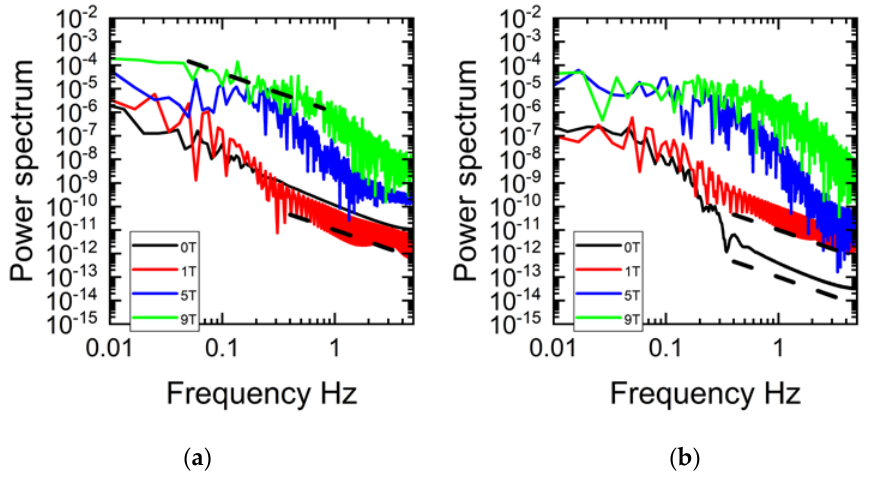
Figure 15. Power spectrum for the velocity components u ( a ) and v ( b ) for the case with ΔT = 5 °C .